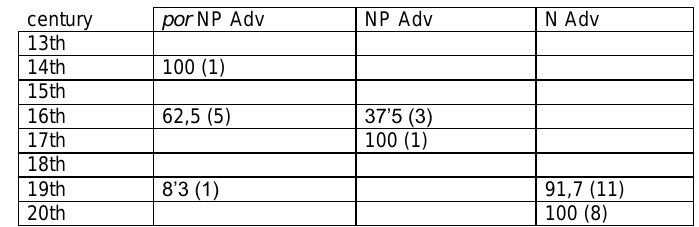
Table 7. Frequency of escalera(s) abajo/ayuso